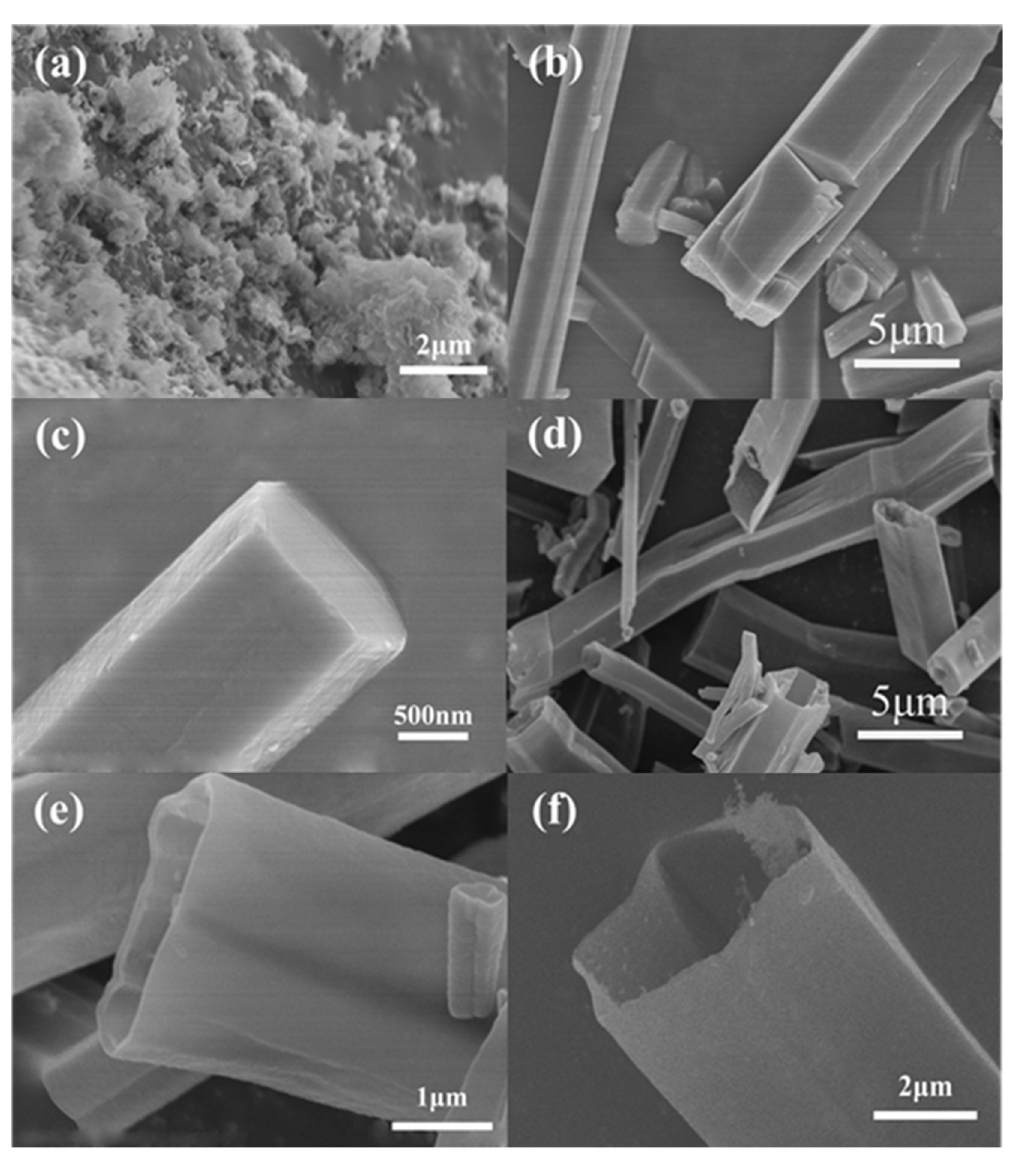
Figure 2. The SEM images of the CNB ( a ), low magnification ( b ), and high magnification ( c ) of the supramolecular precursors, and low magnification ( d ) and high magnification ( e , f ) of the 0.9P-CNT sample.